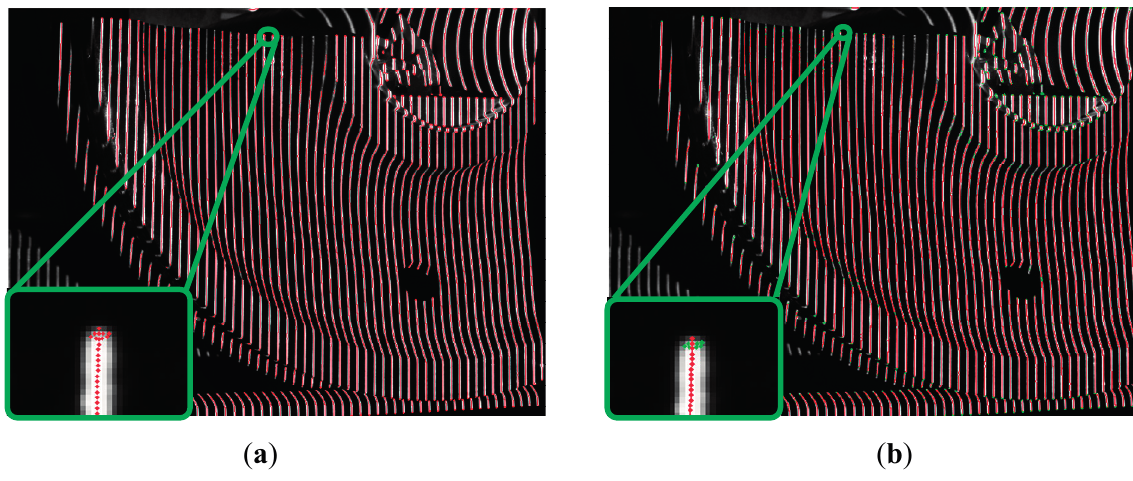
Figure 6. Light stripe extraction results. ( a ) Extraction result of the sub-pixel coordinates of the light stripe center; ( b ) Extraction result of the light stripe center after